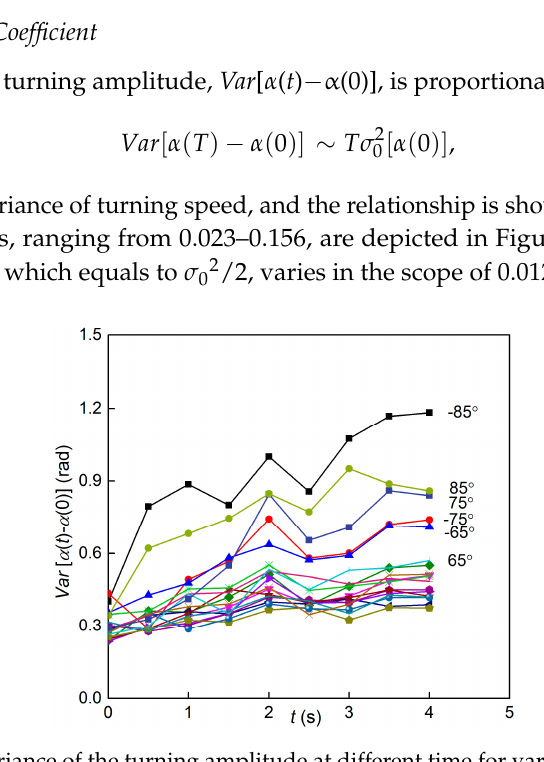
Figure 14. Turning speed of cells at different initial swimming angles.